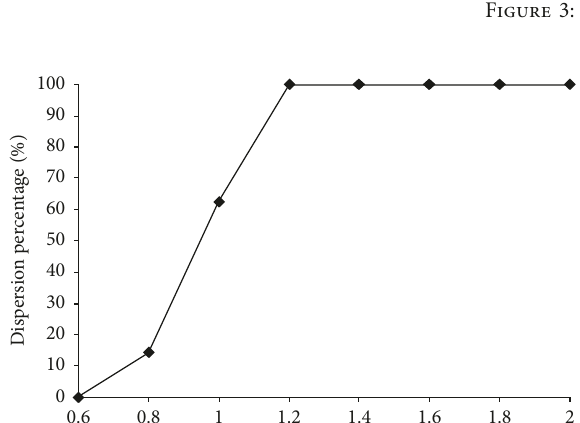
Figure 3: MSG test sieving.